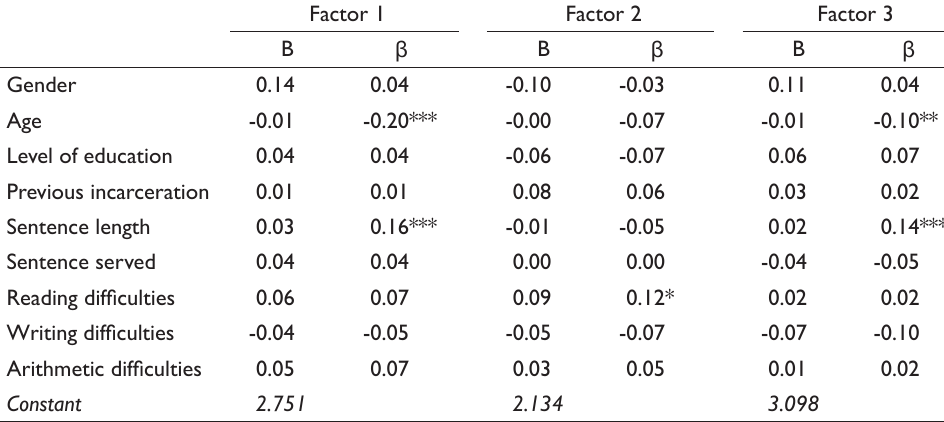
Table 2: Summary of simultaneous regression analyses for variables predicting prisoners’ motive categories for starting an education in prison